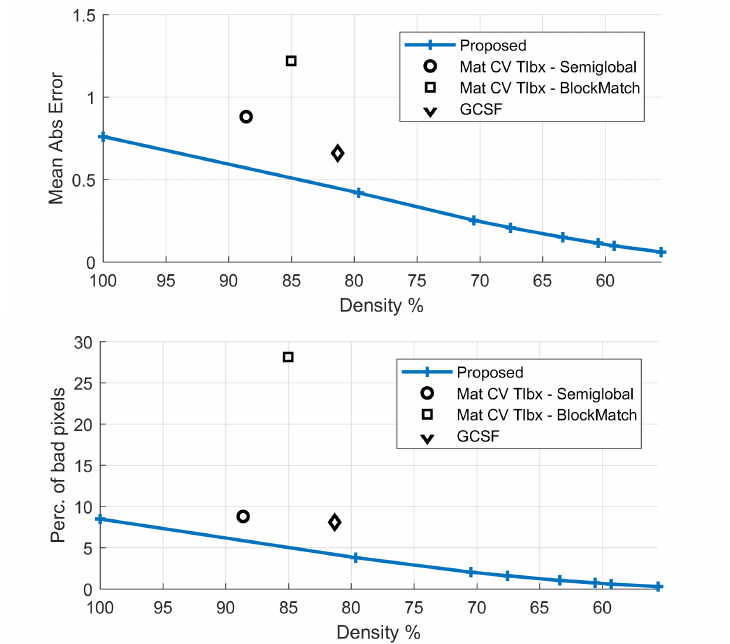
Figure 13. Natural “Dimitris-Chessboard” sequence: comparative results with respect to disparity